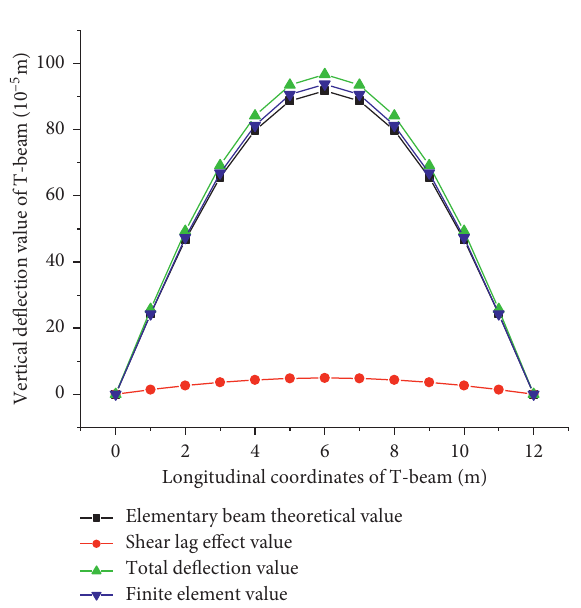
Figure 7: Deflections for simply supported T-beams ( L � 12m, uniform